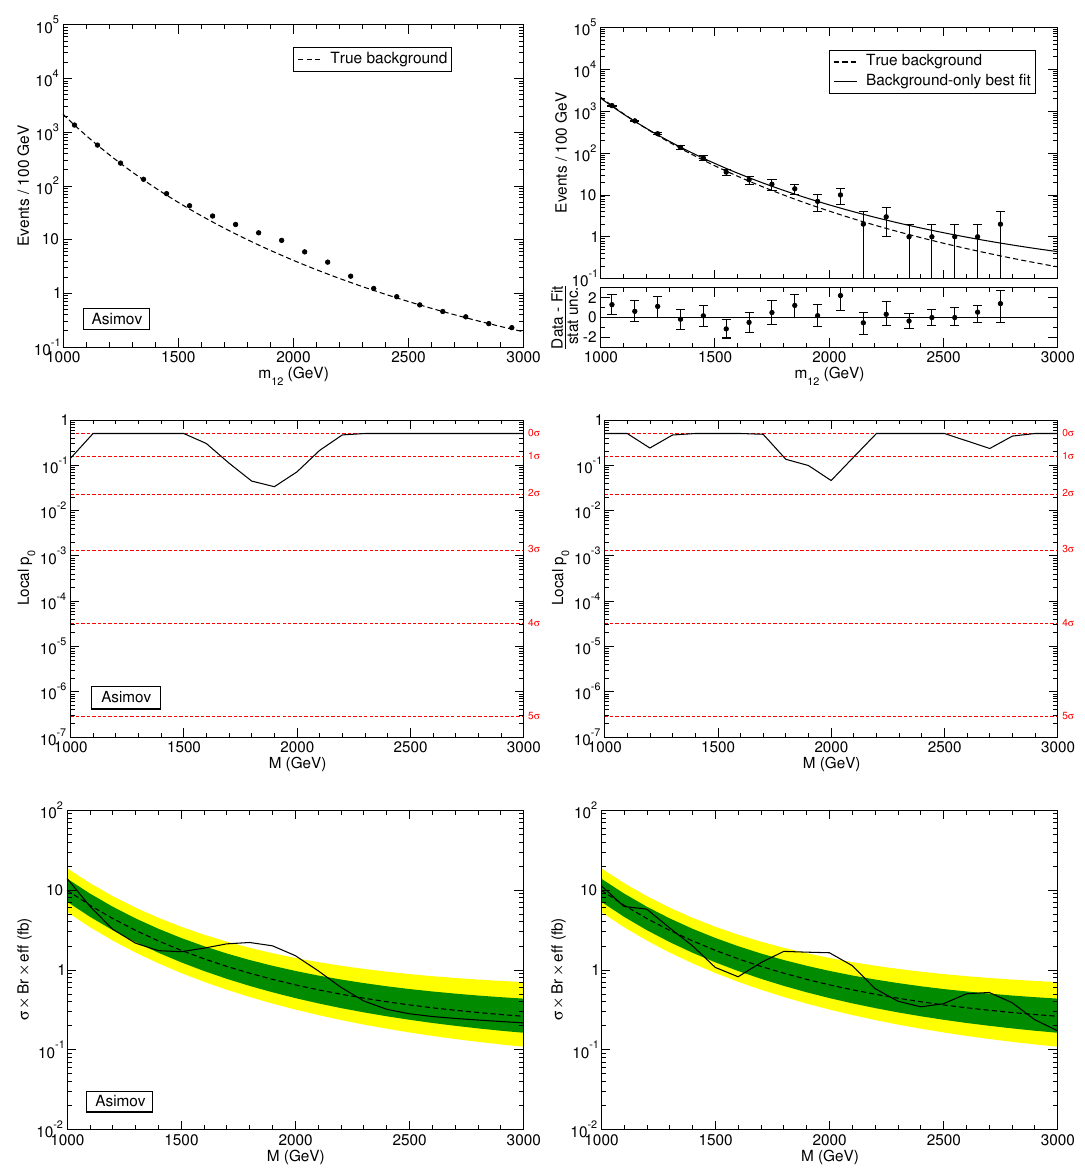
Figure 9 . Top, left: Asimov data for the asymmetric triboson bump in (cid:12)gure 4 (right), with a size of 50 signal events. Top, right: data for a pseudo-experiment. Middle, left: local p -values for the Asimov data. Middle, right: local p -values for the pseudo-experiment. Bottom, left: expected and observed limits for the Asimov data. Bottom, right: expected and observed limits for the